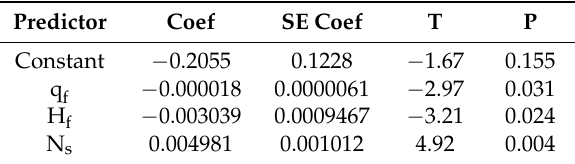
Table 13. Regression equation coefficients.